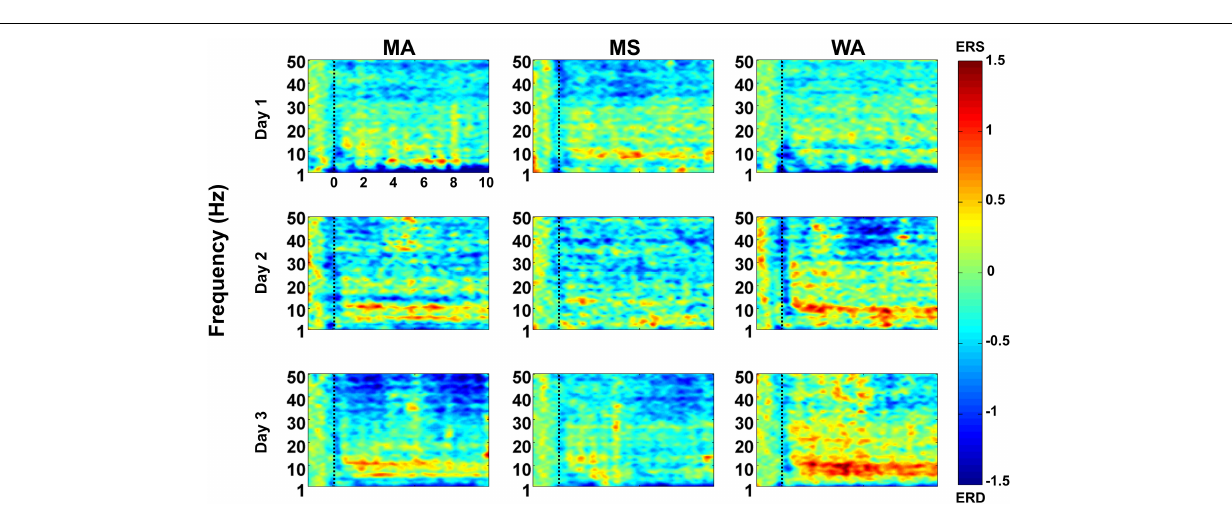
FIGURE 4 | ERD/ERS pattern maps averaged over all channels and subjects over the three experimental days. The x-axis indicates the task period between − 2 to 10 s on the basis of the task onset, and the y-axis represents the frequency ranging from 1 to 50 Hz. The task onset at t = 0 s is marked by a dotted